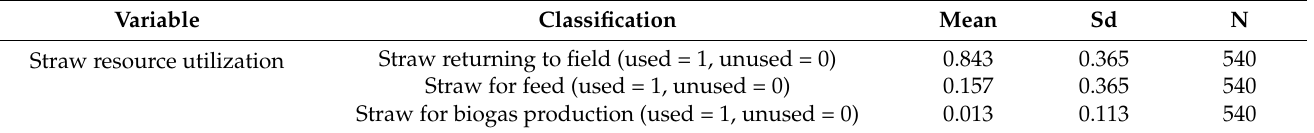
Table 1. Classification of straw resource utilization.